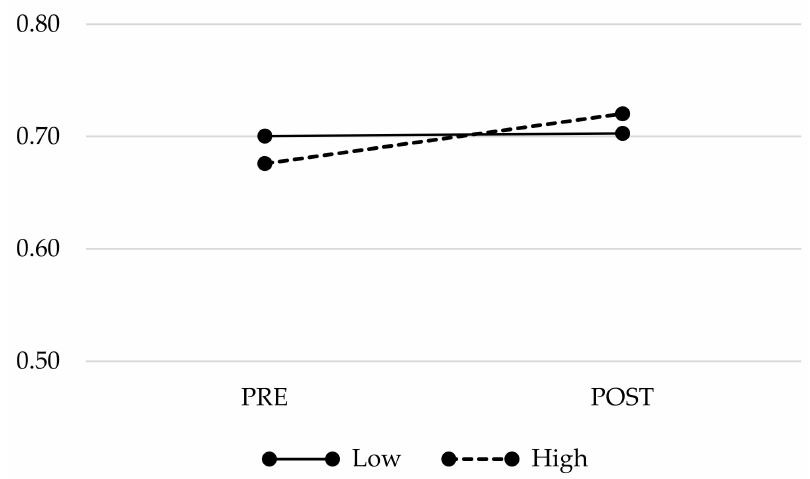
Figure 3. Pre-post gray matter volume’s changes in the BNST in patients presenting higher vs lower increases in Psychological Inflexibility Scale scores (i.e. “High” vs.